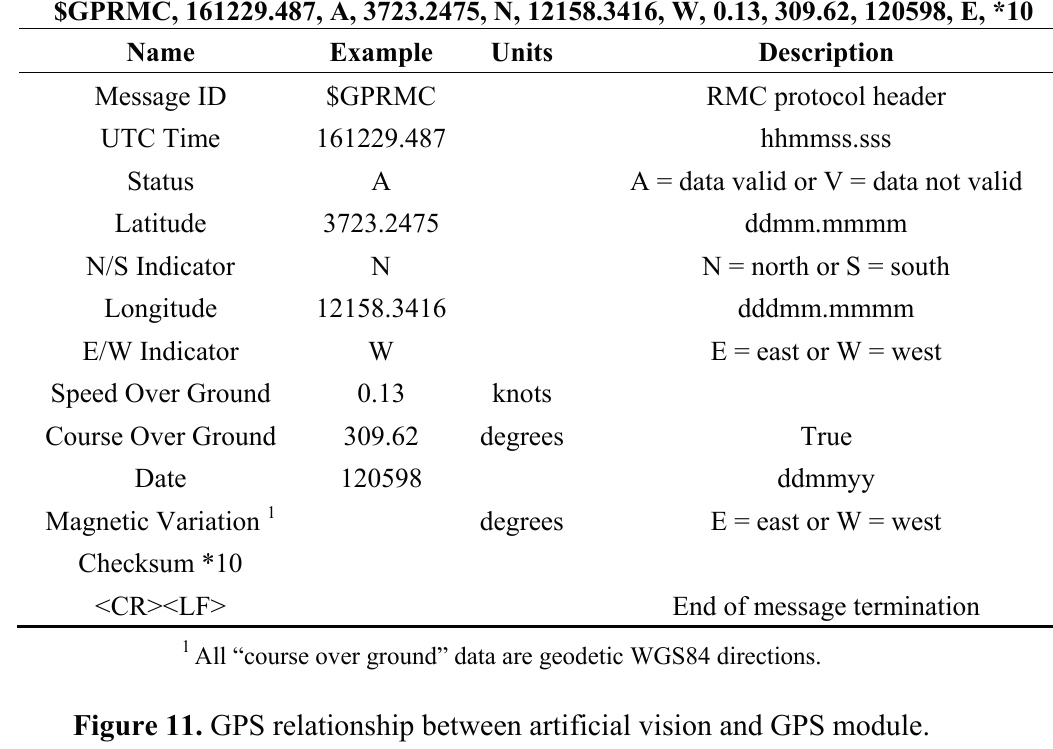
Table 4. RMC—recommended minimum specific GNSS data.